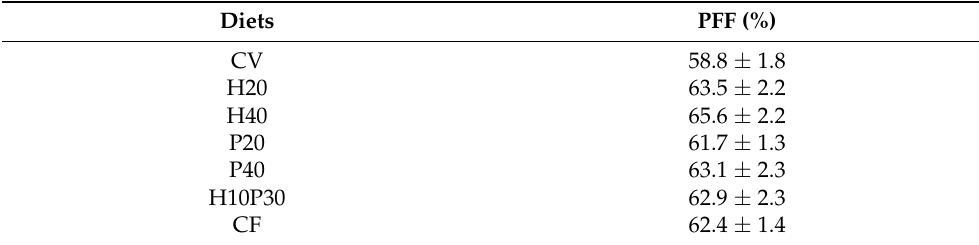
Table 6. Histological evaluation of the percentage of fat fraction (PFF) in liver histological sections. Data are reported as mean ± SD. No significant differences were detected among groups.